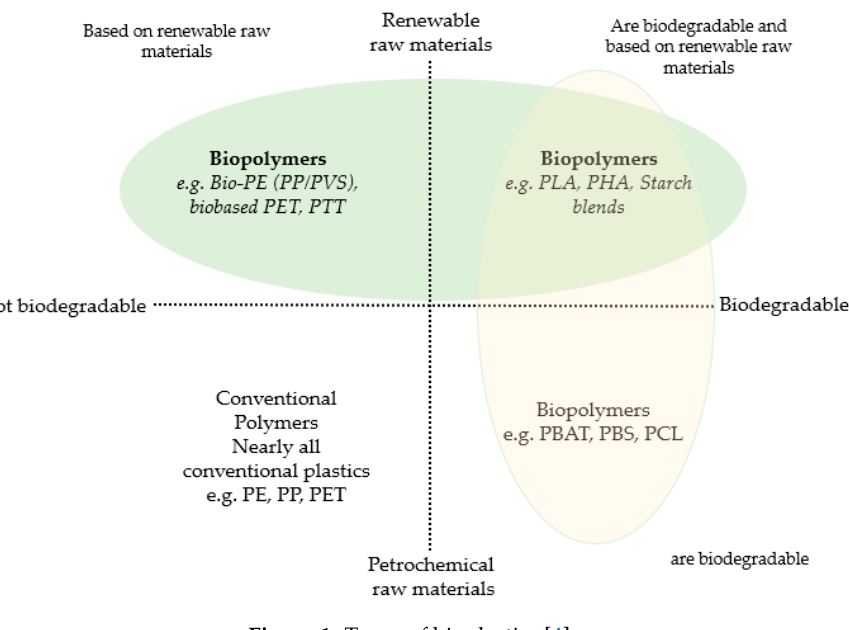
Figure 1. Types of bioplastics [4].